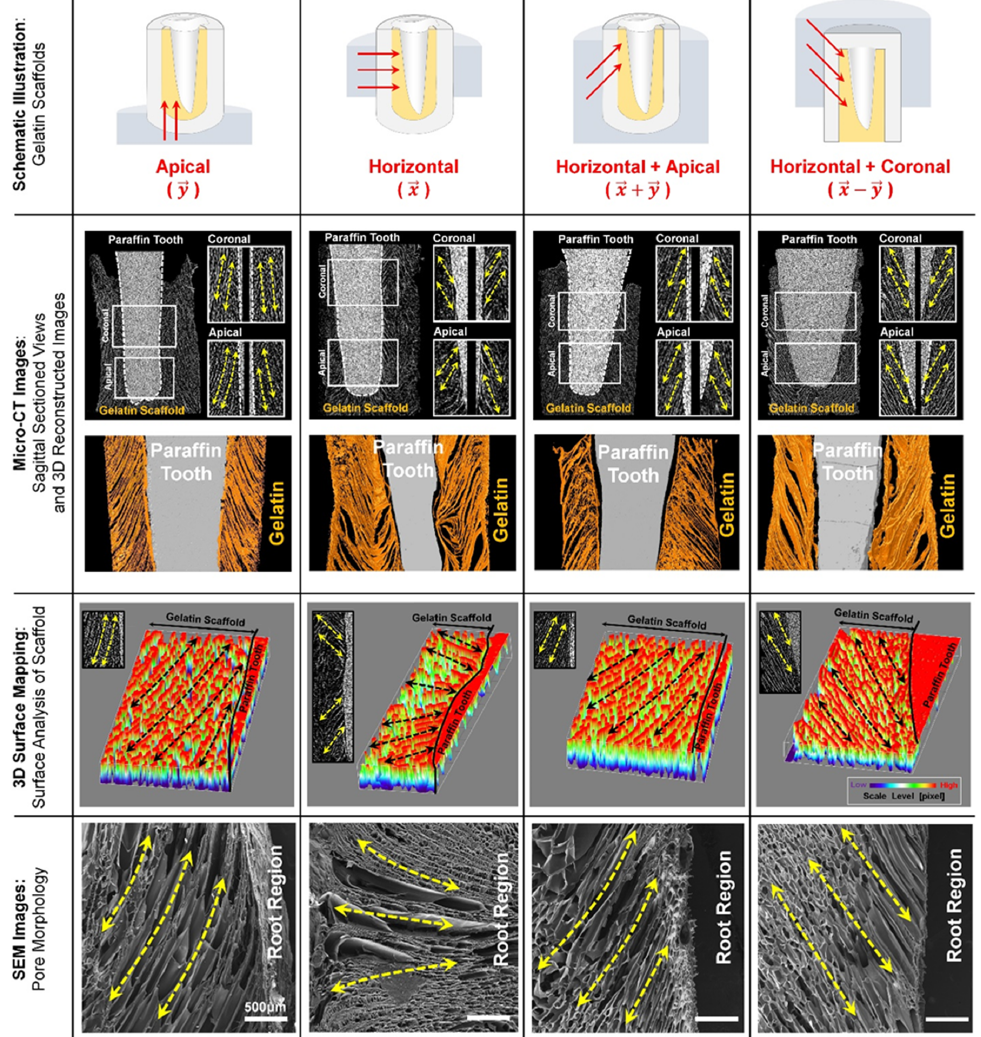
Figure 2. Freeze-casting method for longitudinal pore structures with controlled angulations. Depending on freezing directions (the first row), various angular organizations of internal pore architectures were created and analyzed using micro-computed tomographic images with both digitized 2D cross-sectional and 3D reconstructed images (the second row), 3D surface mapping to show angulations to the surface of the para ffi n tooth (the third row), and scanning electron microscopic (SEM) images for morphologies (the fourth row). Adapted with permission from the reference